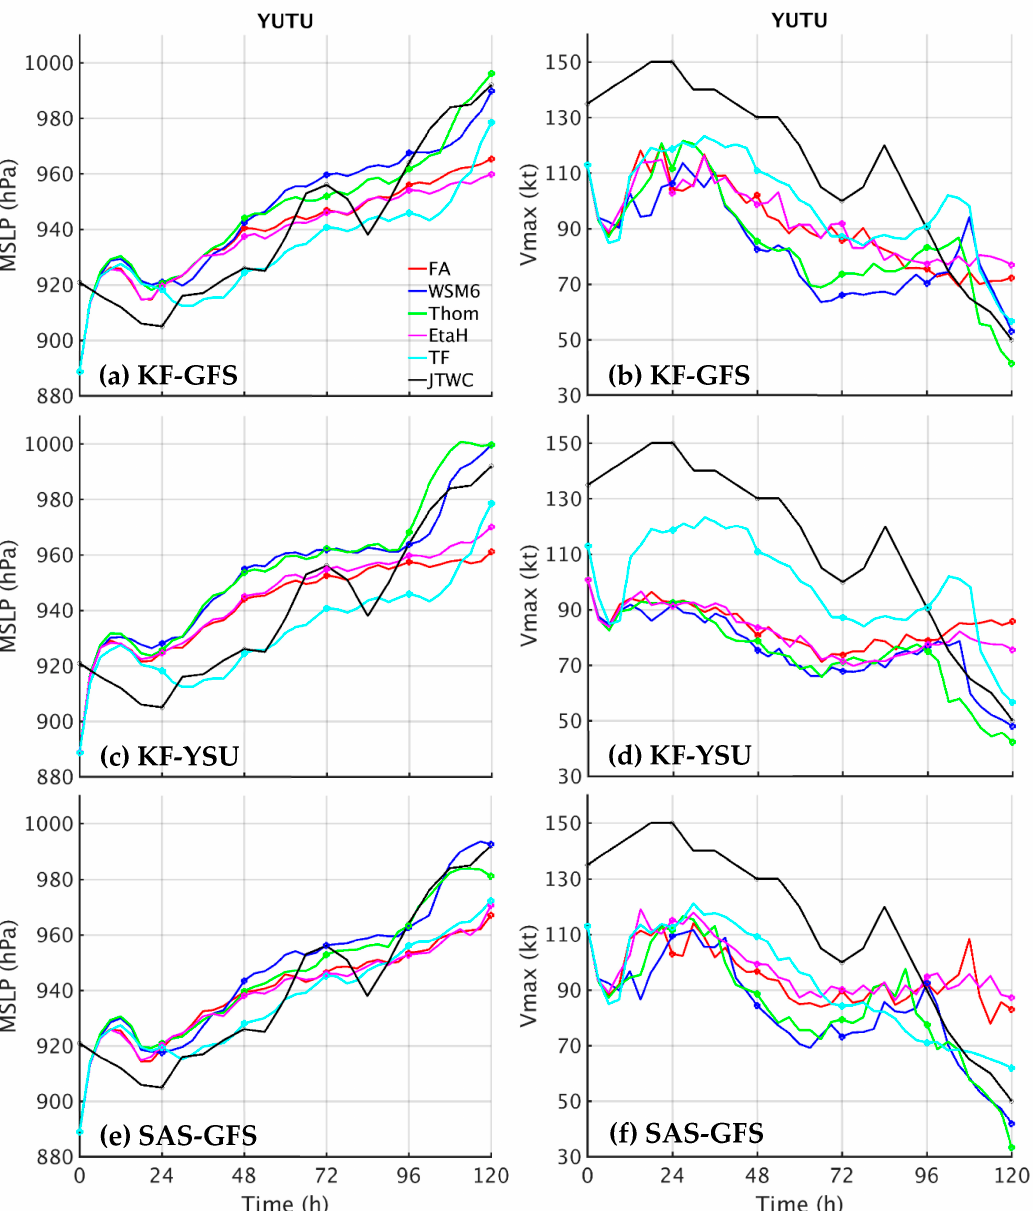
Figure A3. Time evolution of simulated minimum sea-level pressure (hPa) for Yutu from 0000 UTC 26 October to 0000 UTC 31 October 2018 for the scheme combination of ( a ) KF–GFS, ( c ) KF–YSU, and ( e ) SAS–GFS. ( b ), ( d ), and ( f ) are the same as in ( a ), ( c ), and ( e ), respectively, but for 10 m maximum wind speed (kt) for a forecast of total 120 h. The red, blue, green, magenta, and cyan lines denote the cloud-microphysics schemes FA, WSM6, Thom, EtaH, and TF, respectively. The best track intensity is from the JTWC (black line).